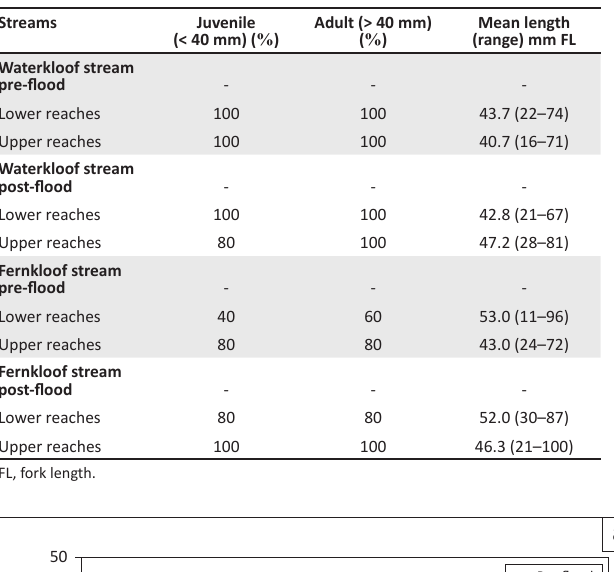
TABLE 3: The frequency of occurrence ( % of sites containing Pseudobarbus afer ) of juvenile (< 40 mm) and adult (> 40 mm) Pseudobarbus afer pre-flood and post-flood separated by stream reach (lower and upper) for the Fernkloof and Waterkloof streams headwater tributaries of the Kwa-Zunga River within the Groendal Wilderness Area.